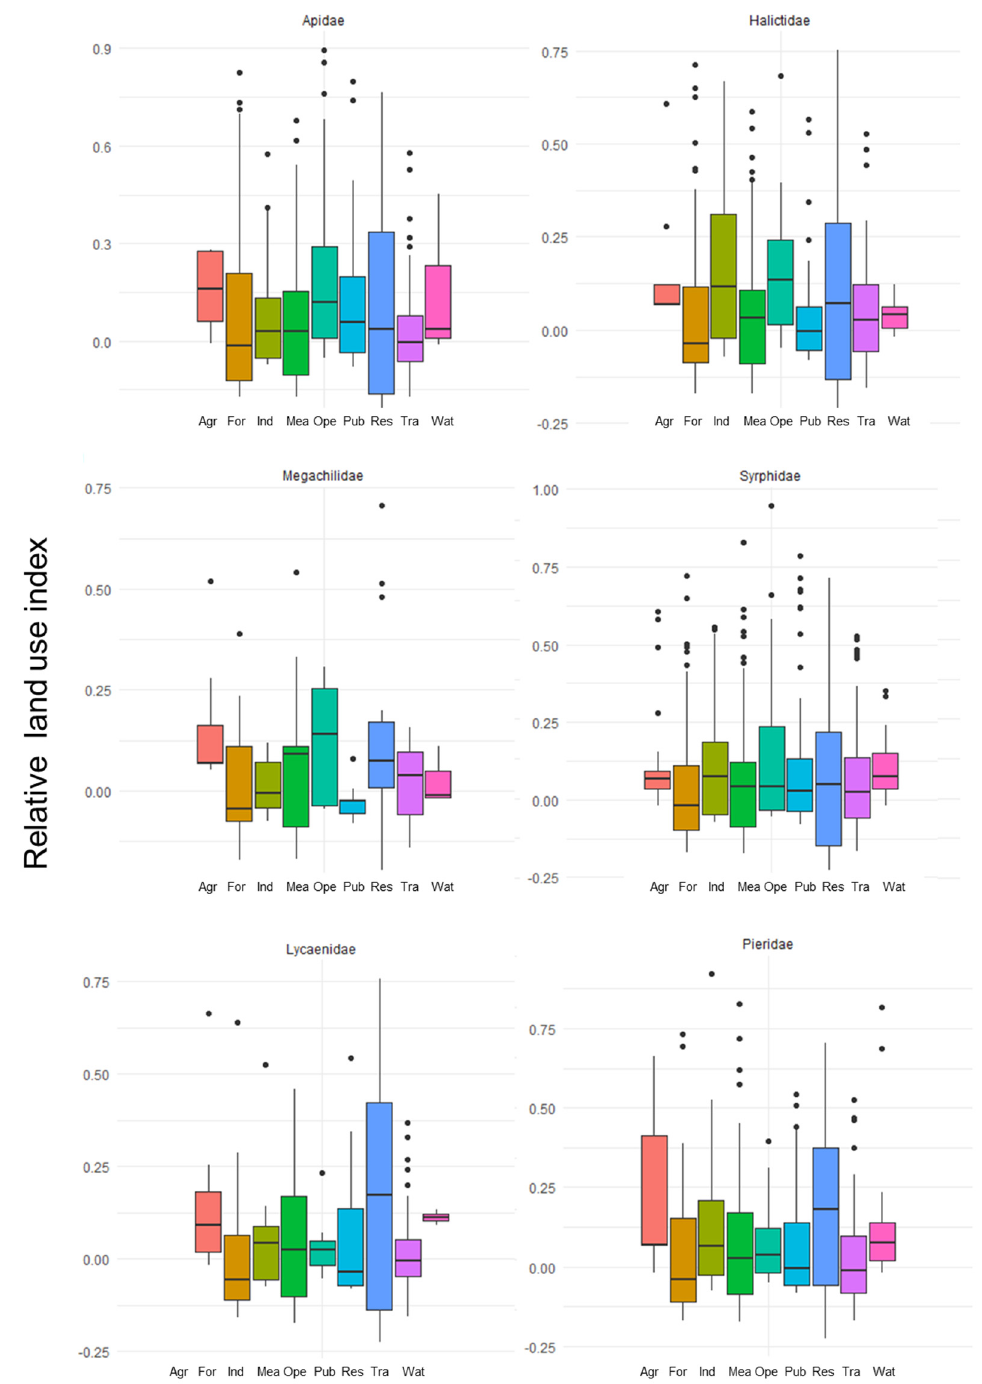
Figure 3. Relative land use affinity according to six land-use classes among the most frequent pollinators genus observed in Seoul between 2016 and 2018 (Agr: agriculture; For: forest; Ind: industrial and commercial areas; Mea: meadows and grasslands; Ope: open and mineral areas; Pub: public and cultural facilities; Res: residential areas; Tra: transportation, Wat: wetlands and water).